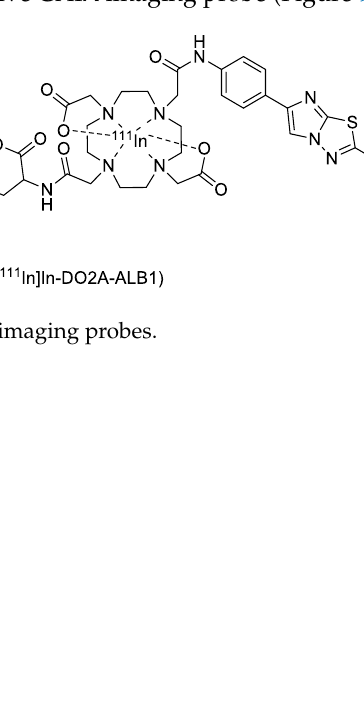
Figure 9. Coronal SPECT/CT images of an HT-29 tumor-bearing mouse obtained at 24 h PI using IS- [ 111 In]In-DO2A-ALB1 and [ 111 In]In-DO3A-IS1.